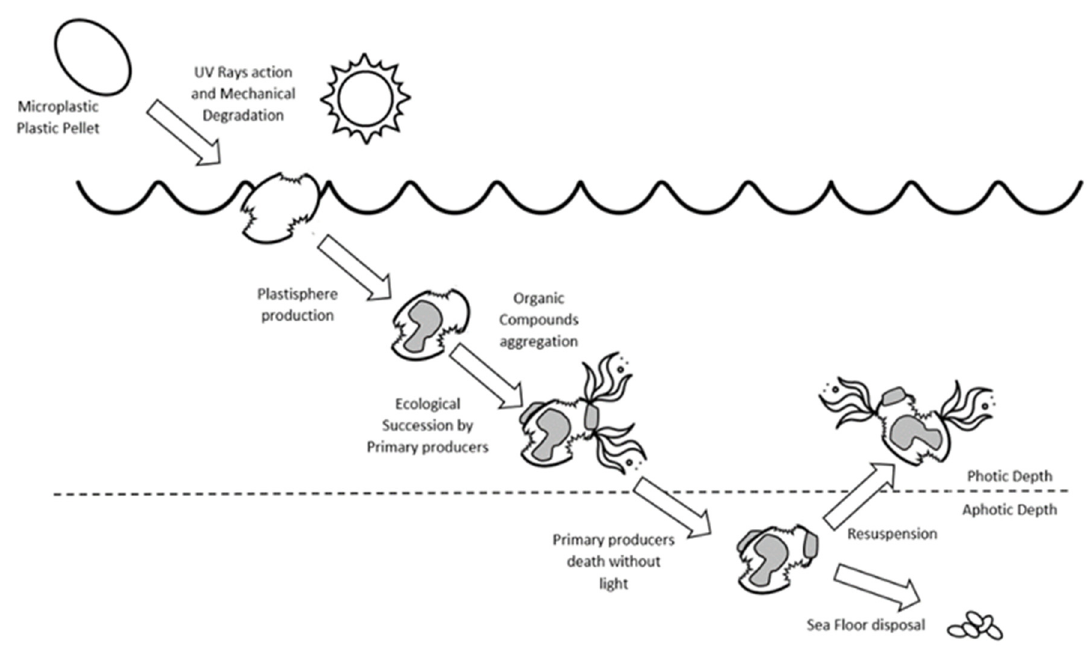
Figure 3. The various stages of the biofouling process.